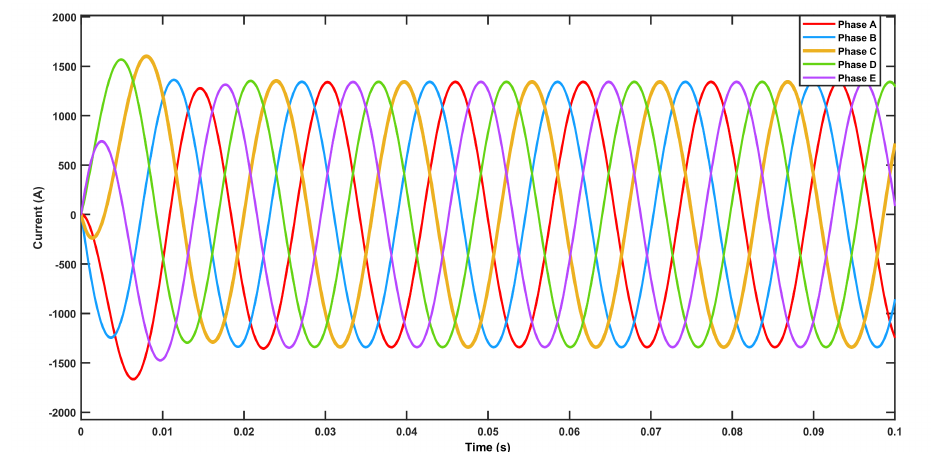
Figure 5. Schematic of five-phase single–turn motor driver